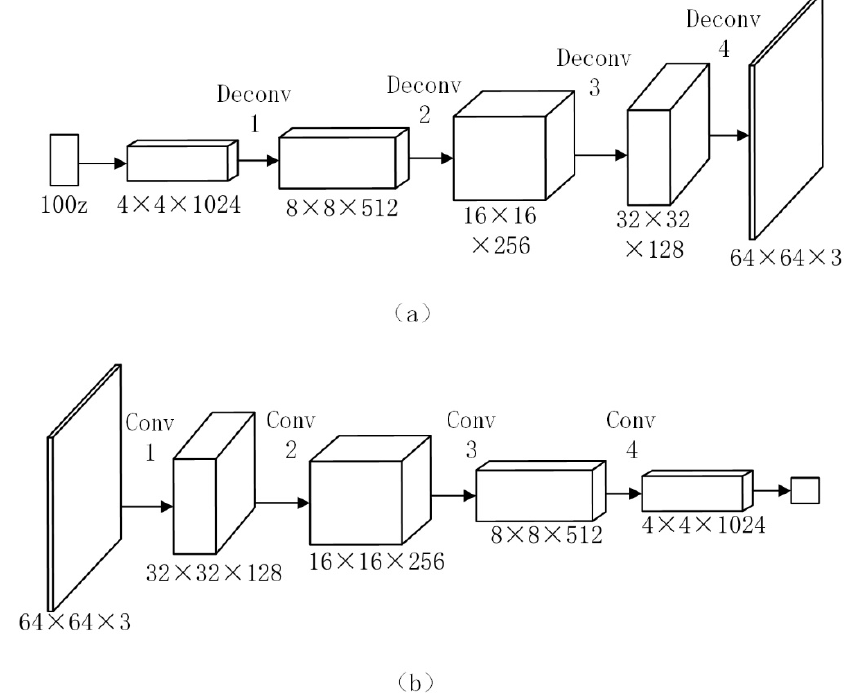
Figure 5. G and D network block structure.